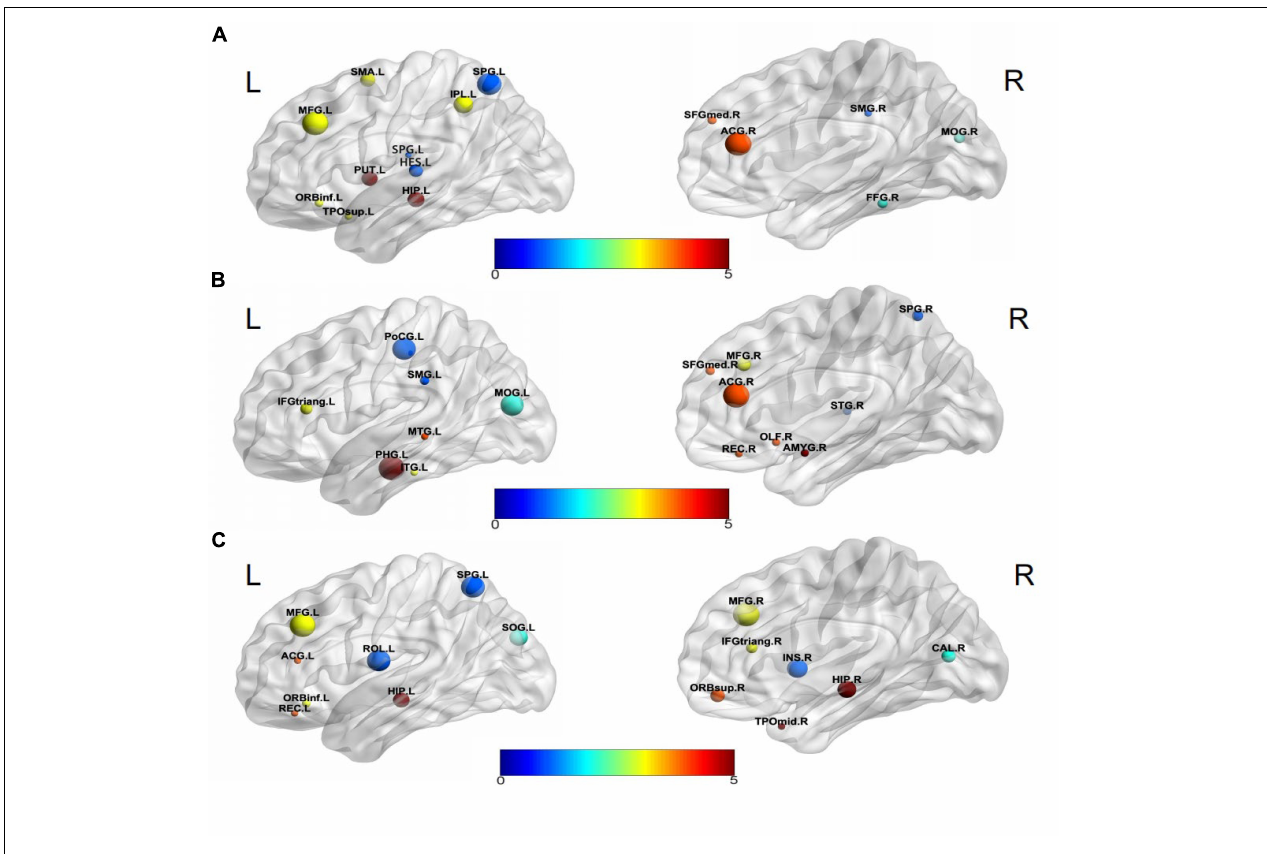
FIGURE 5 | Visualization of discriminative brain regions. (A) AD-HC, (B) AD-EMCI, and (C)